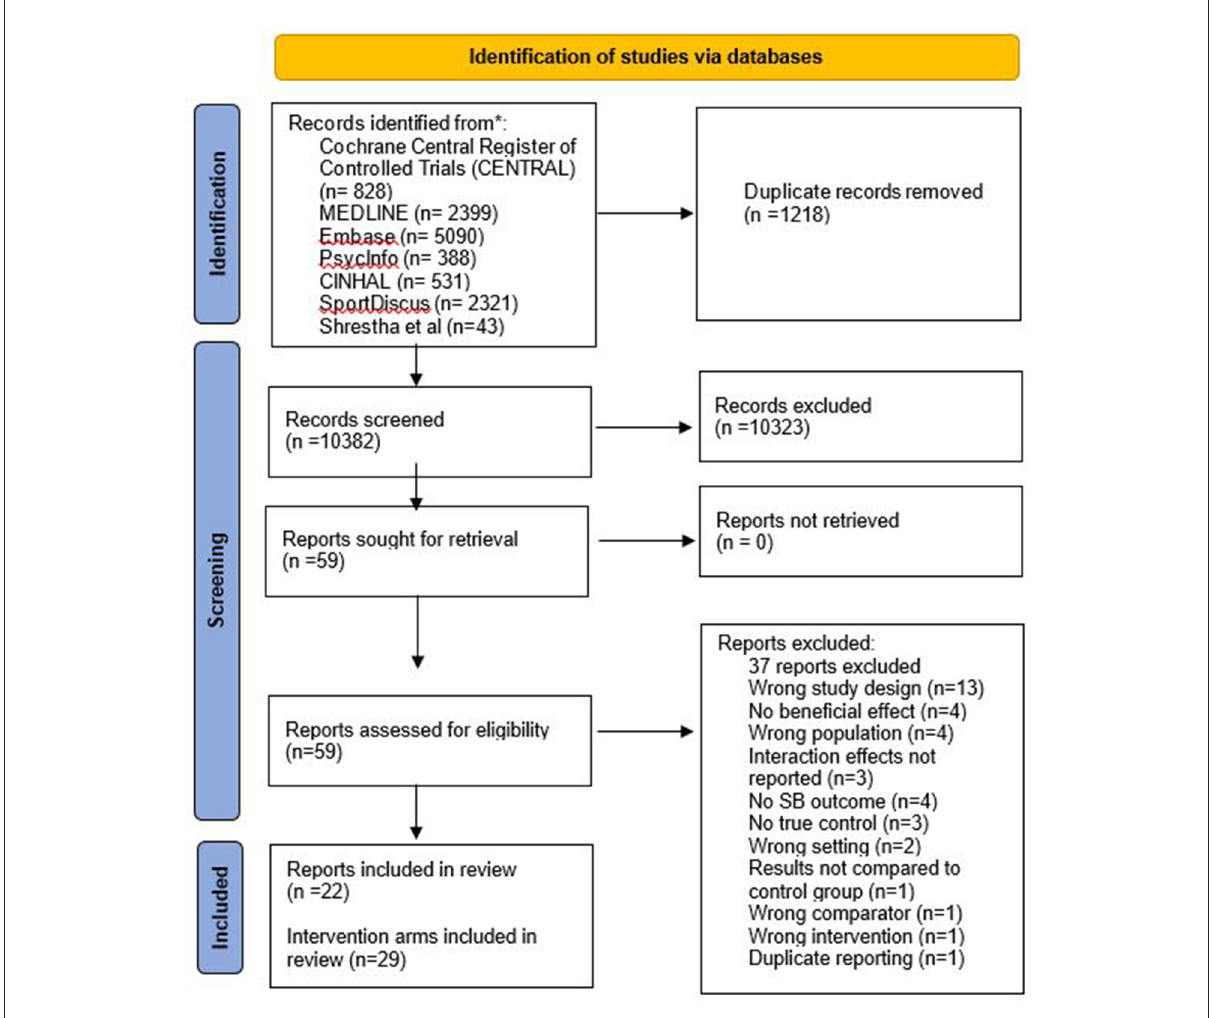
FIGURE1 PRISMA flow diagram obtained from Covidence showing the study selection process.